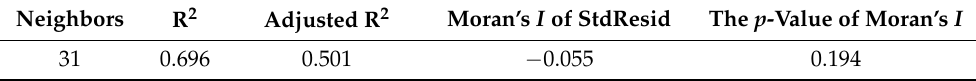
Figure 5. The standardized value of GWR prediction and real natural hazard events. Table 6. Summary of